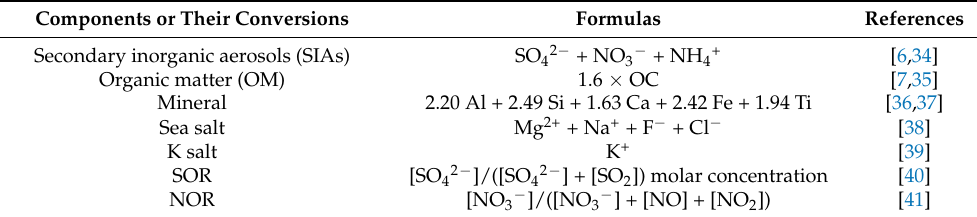
Table 1. Formulas and references of main components in PM 2.5